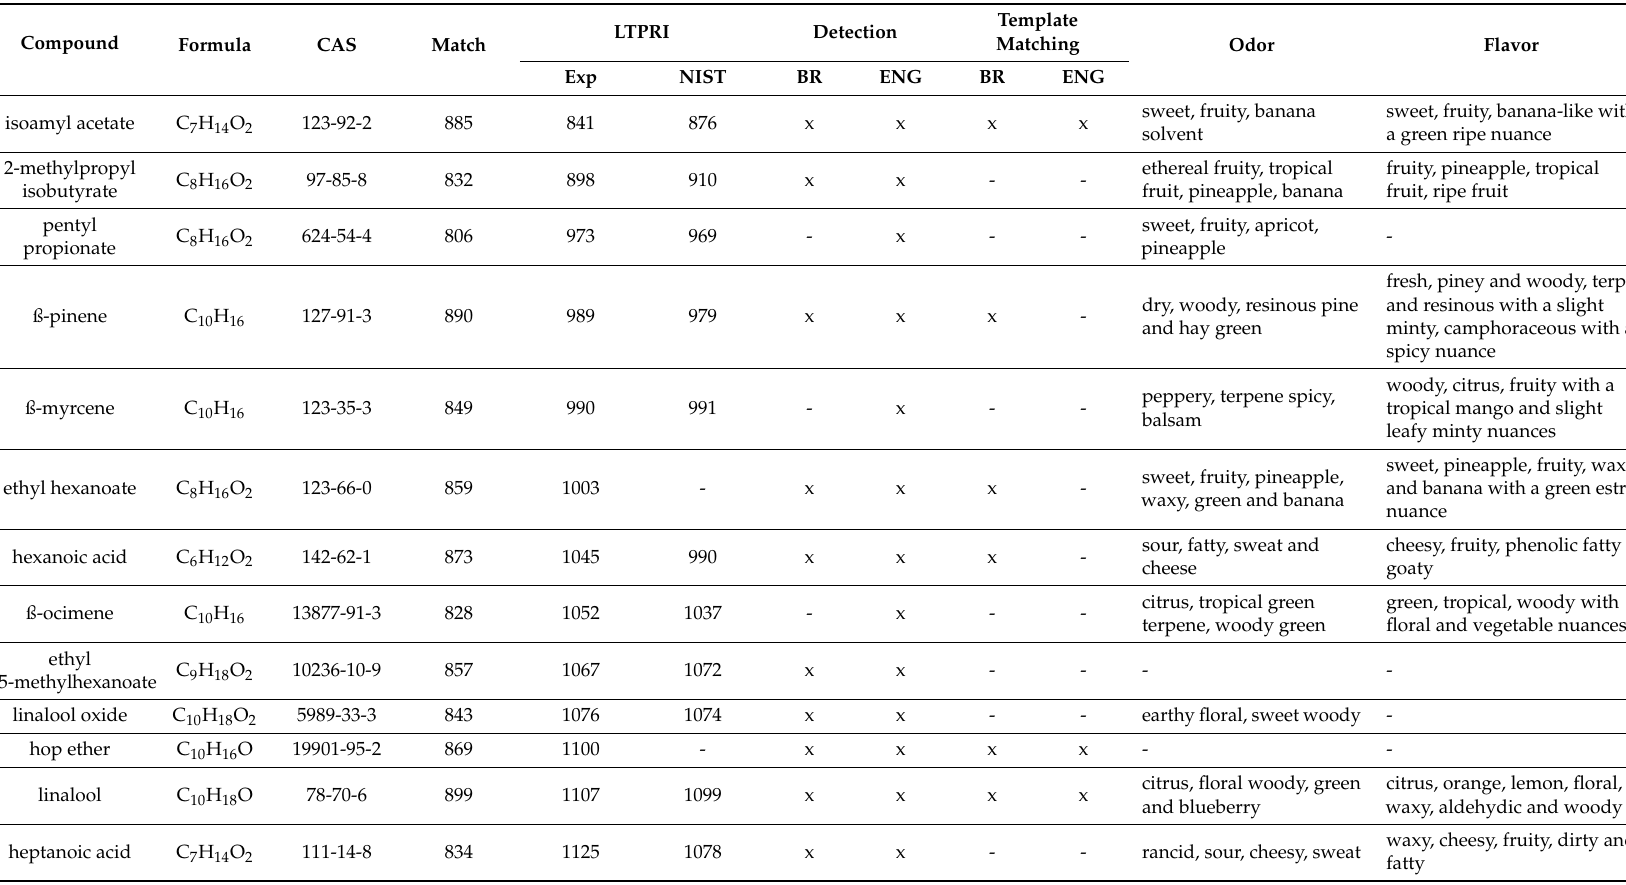
Table 1. Analytes identified in the volatile and semi-volatile fraction of the ENG and BR samples by HS-SPME and GC × GC-QMS. Linear temperature programmed retention index (LTPRI) were obtained from NIST. All analytes were identified by considering a minimum similarity match of 800 and a ± 25 LTPRI deviation from NIST Web Book. The detection of volatile organic compounds in BR and ENG samples is also indicated. Template matching refers to the assignment of class-specific peaks using a mixed data analysis approach, namely, multiway principal component analysis and template matching. The odor and flavor attribution were acquired from The Good Scents Company